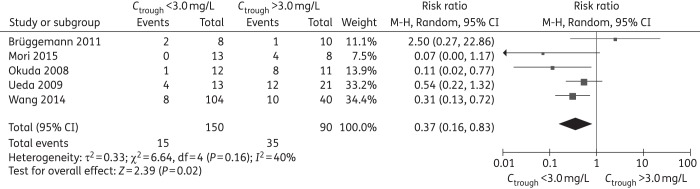
Meta-analysis for incidence of hepatotoxicity (trough concentration of <3.0 mg/L comparison with >3.0 mg/L, RR <1 favours Ctrough <3.0 mg/L).